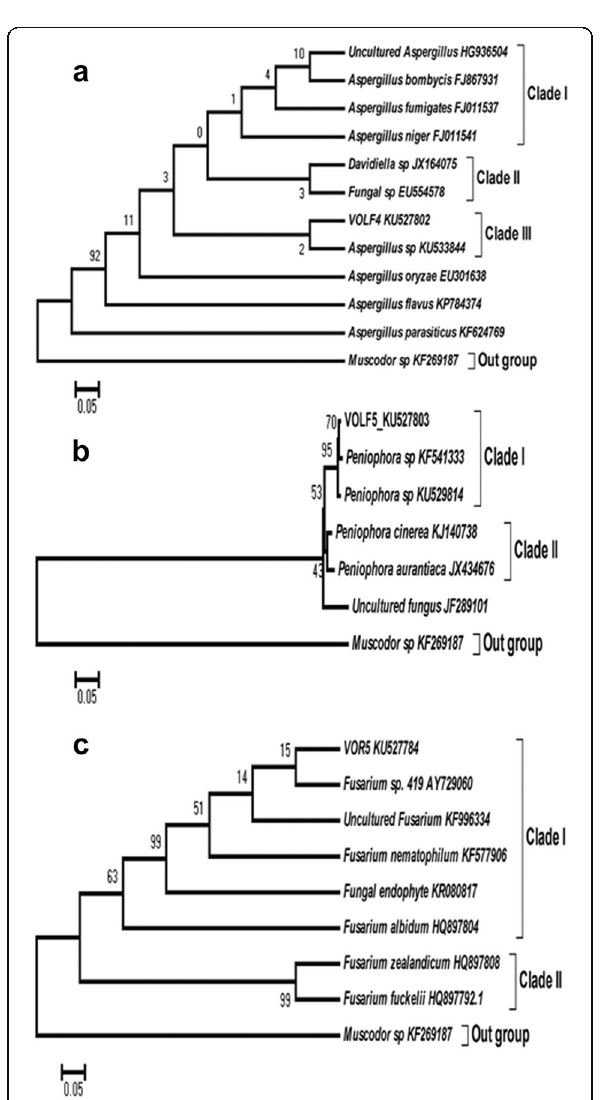
Fig. 2 Phylogenetic tree showing rDNA based (ITS region) molecular taxonomy and phylogenetic analysis of bioactive endophytes a ) VOLF4 b ) VOLF5 c )